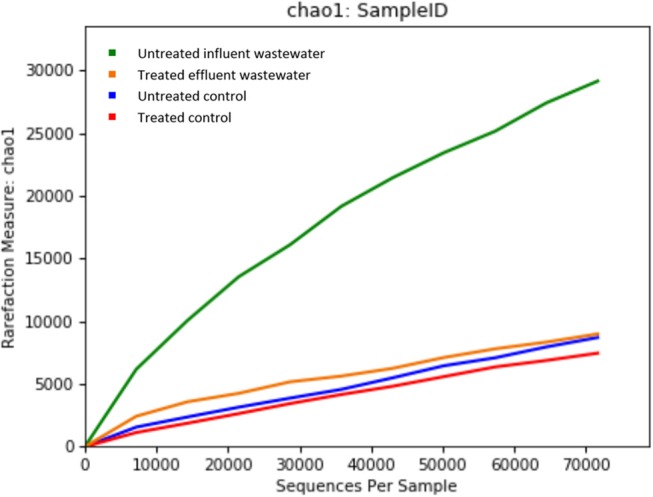
Alpha rarefaction curves calculated for (A) chao1 index demonstrating higher diversity of isolates in untreated influent and (B) observed OTU diversity between untreated influent and treated effluent samples.